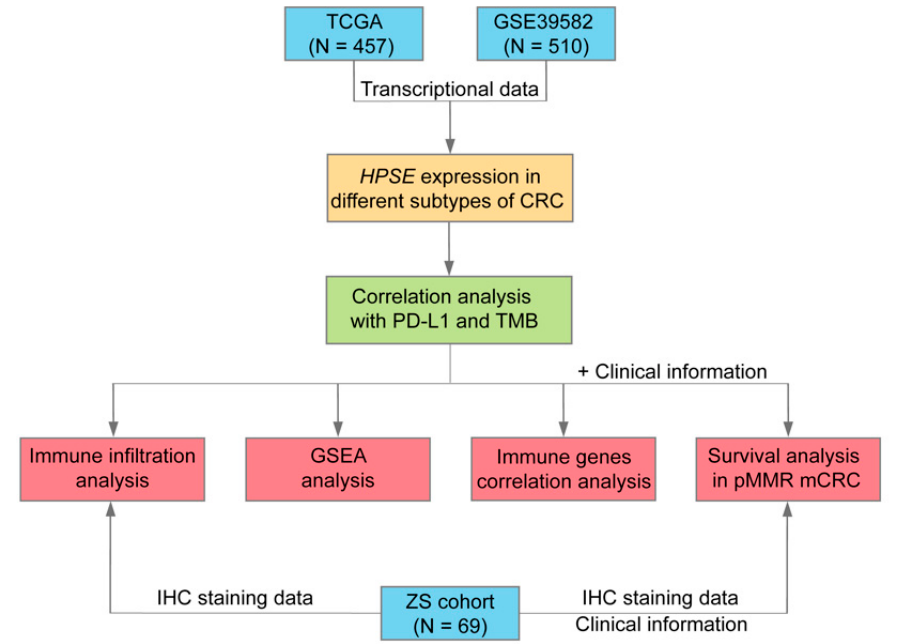
Figure 1. The flowchart of this study. CRC, colorectal cancer; TMB, tumor mutation burden; GSEA, Gene set enrichment analysis; pMMR, mismatch repair-proficient; mCRC, metastatic colorectal cancer; IHC, immunohistochemical staining. Table 1. The clinical characteristics of patients with CRC in TCGA, GSE39582, and the ZS cohort.